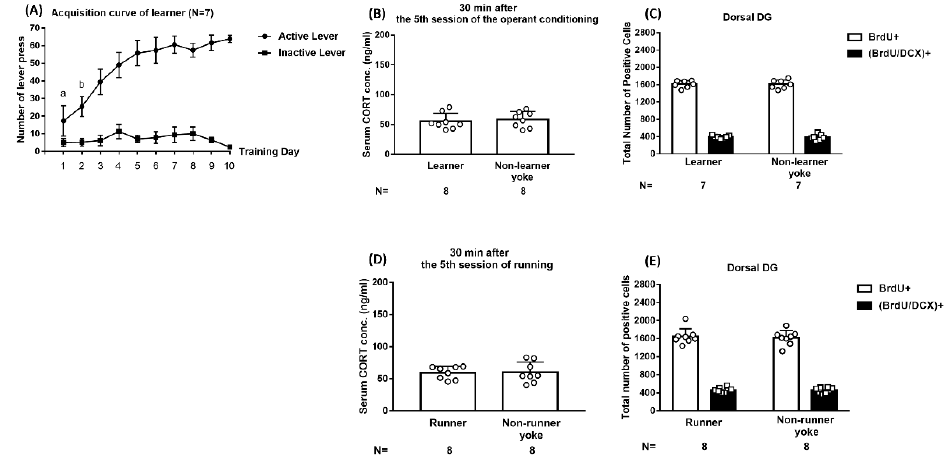
Figure 2. Impact of operant conditioning and forced running on corticosterone (CORT) secretion and short-term neurogenesis in the dorsal DG. ( A ) Mouse learners had comparable lever-pressing numbers on days 3–10 of the regimen. a Significantly lower than the remaining 9 days. b Significantly lower than days 3–10. ( B ) Learner and non-learner yoke mice had comparable serum CORT levels 30 min after the conclusion of the 5th day ’s training session. ( C ) Learner and non-learner yoke mice had comparable numbers of BrdU+ and (BrdU/DCX)+ cells in the dorsal DG. ( D ) Runner and non-runner yoke mice had comparable serum CORT levels 30 min after the conclusion of the 5th day of the running session. ( E ) Runner and non-runner yoke mice had indistinct numbers of BrdU+ and (BrdU/DCX)+ cells in the dorsal DG. Data are plotted as mean + SD. Neurons in the Dorsal DG at 6 Weeks after the 10-Day Stressor Regimen To gauge the differentiation and maturation of previously BrdU-labeled cells, BrdU and NeuN co-staining methods were used at 6 weeks after the conclusion of the stressor regimen. While 12 IS and control mice had a comparable number of BrdU/NeuN-positive cells, 12 ES mice had a greater number of BrdU/NeuN-positive [F(2,33) = 20.66, p < 0.0001] cells in dorsal DG as compared to IS and controls (Figure 3A,B). In contrast, three groups of mice ( n = 24) had sparse and indistinct BrdU/GFAP-positive cells in this regard (Supplementary Figure S2). To further test whether those BrdU-labeled mature neurons may be integrated into extant circuitry at this time point, kainic acid-induced seizures and Arc protein co-labeling methods were used. Eight ES mice displayed a greater number of BrdU/NeuN/Arc-positive cells in the dorsal DG as compared with the 8 non-stressed control and IS mice [F(2,21) = 22.76, p < 0.0001] (Figure 3C,D). The latter two groups of mice had an indistinct number of BrdU/NeuN/Arc-positive cells in the dorsal DG (Figure 3C,D). An implication of these results is that the majority of the 6-week-old, adult-born neurons are incorporated into the existing circuits in the dorsal DG.